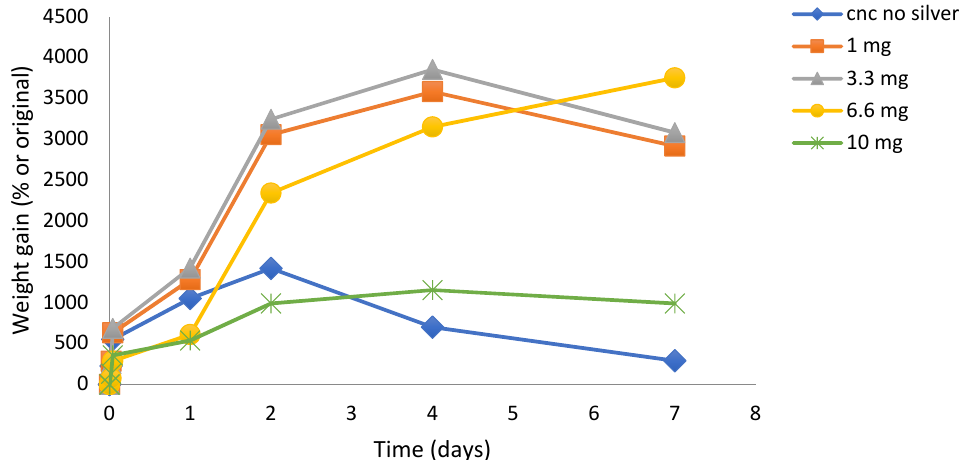
Figure 4. Time course of swelling of SDF loaded CNC hydrogel films (1–10 mg) in water. Loadings describe weight of silver in 500 mg manufactured films, thus 10 mg is equivalent to 2% w / w silver loading in CNC.